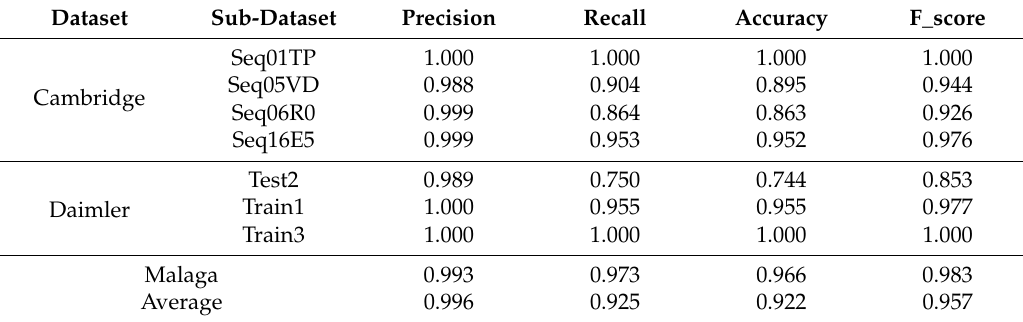
Table 5. Accuracies by our proposed method for different datasets.